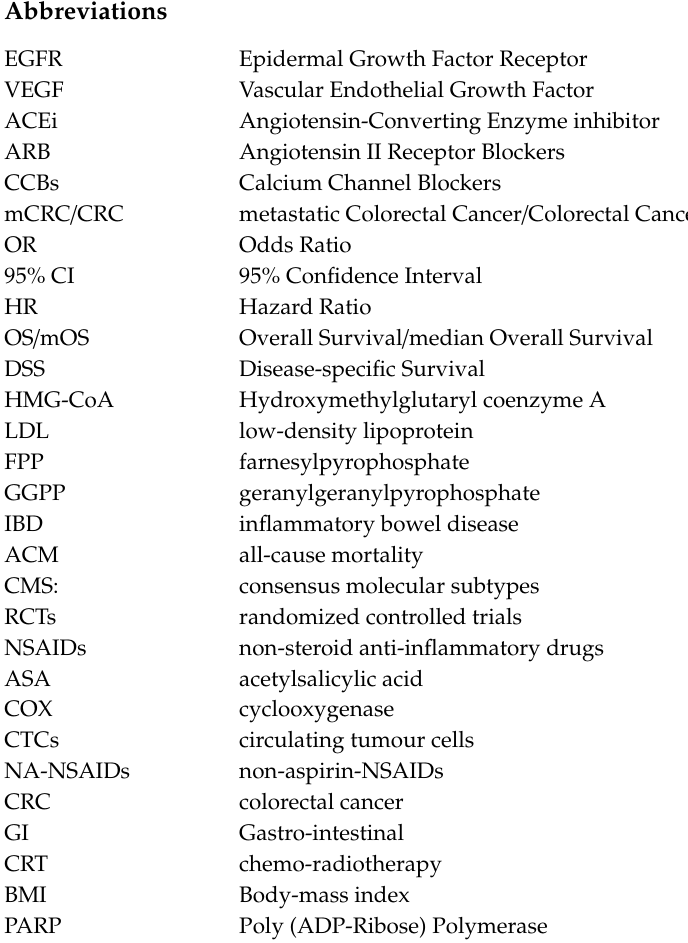
Table S1: Summary of studies for drugs cited in the review, listed by e ff ect on colorectal cancer incidence. Author Contributions: Conceptualization, R.G.; methodology, R.G. and L.C.; software, R.G.; validation, R.G., L.C.; formal analysis, R.G.; investigation, A.L. (Andrea Lanese); data curation, F.P.; writing—review and editing,